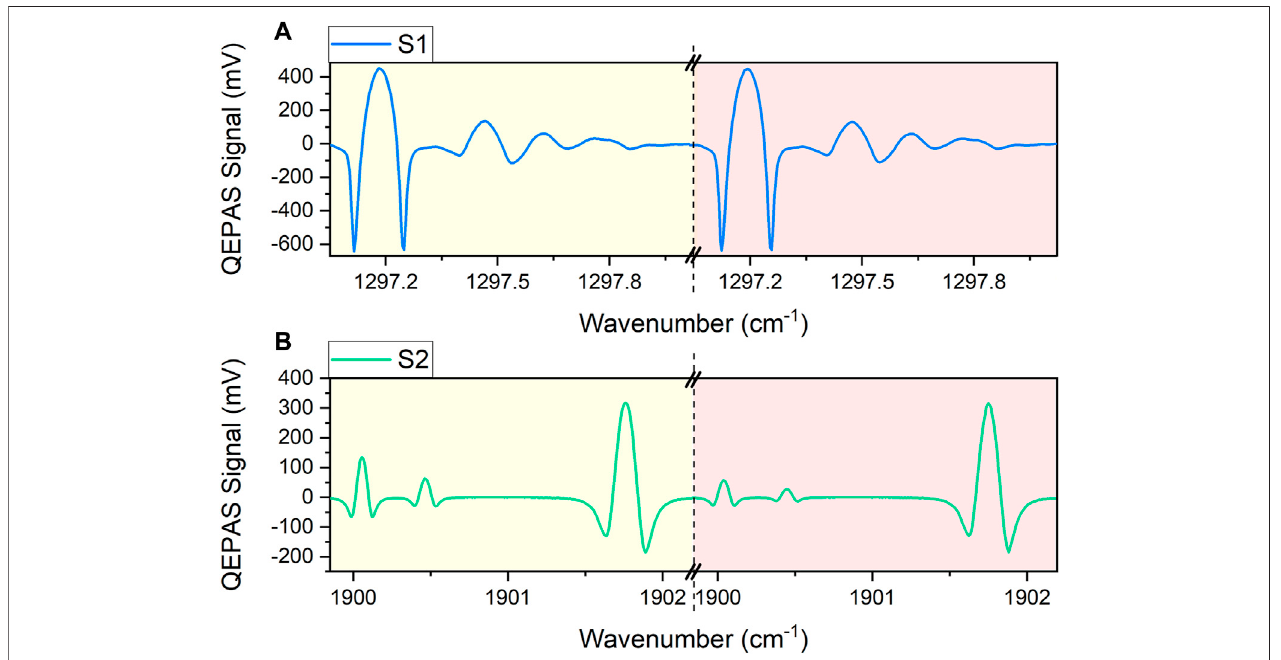
FIGURE 9 | QEPAS signals acquired targeting two different gas samples in consecutive acquisitions by simultaneously operating sensors (A) S1 and (B) S2. Spectra of the gas mixture containing 30 ppm of CH 4 , 1.8% of H 2 O and 7 ppm of NO, in N 2 , are shown with a yellow background, while spectra of the gas mixture containing 30 ppm of CH 4 , 1.8% of H 2 O and 3 ppm of NO, in N 2 , are shown with a pink background. The dashed line indicates the end of the sawtooth ramp, corresponding to the change of gas mixture composition.